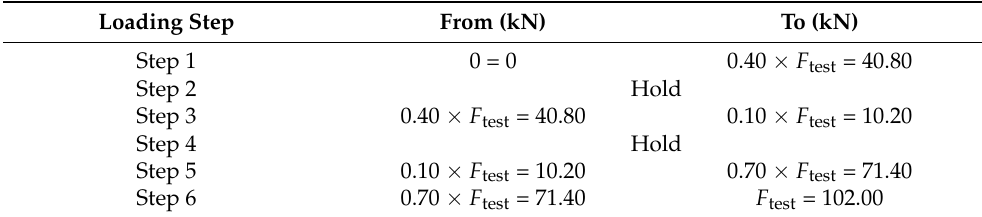
Table 1. The course of test of the experiment setup no. 1, bolts and pins.